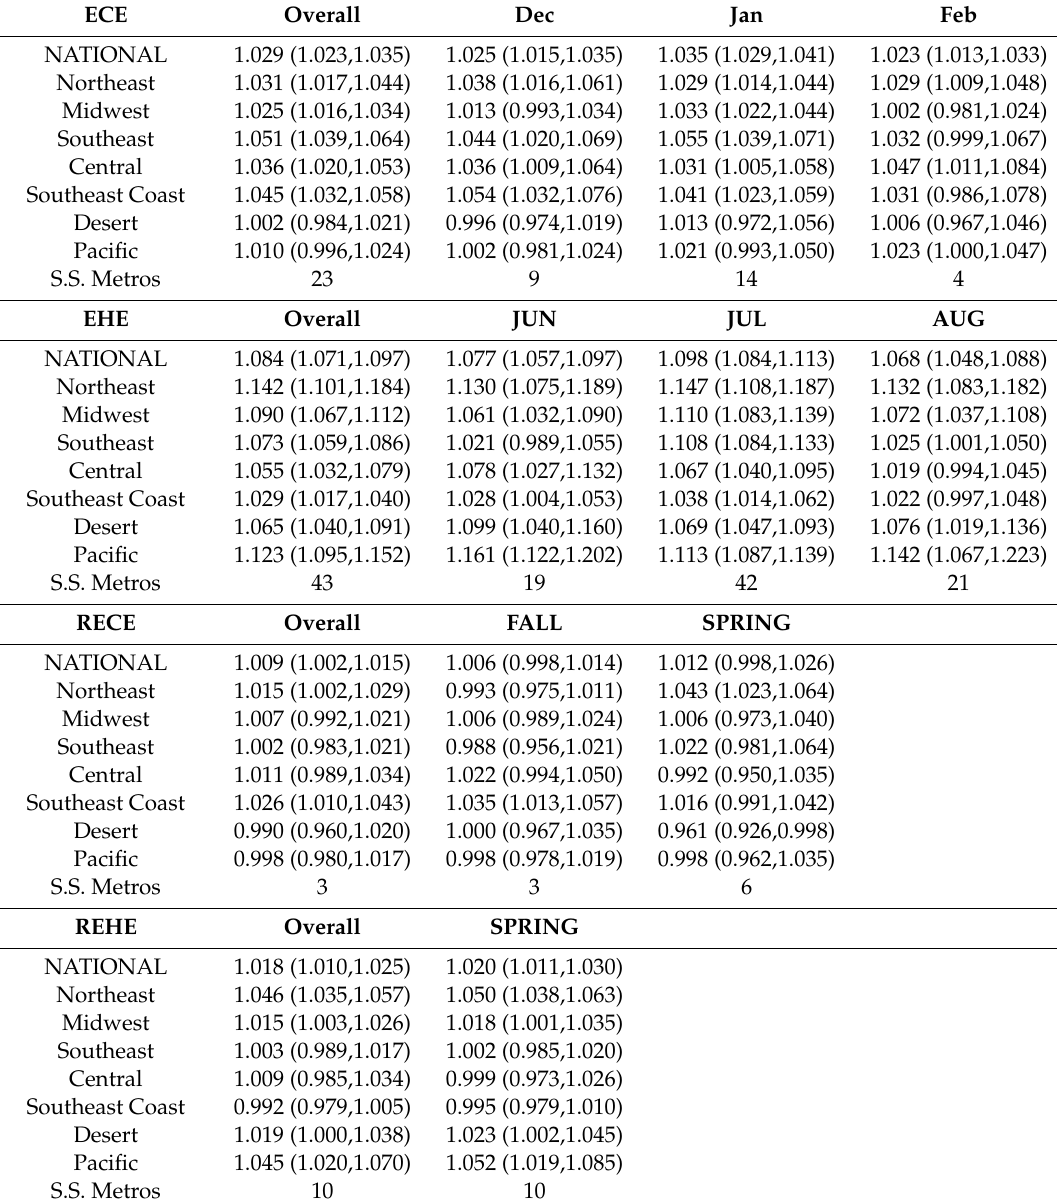
Table 4. Zero-dayrelativerisksforETEsbyregion,andnumberofstatisticallysignificantmetropolitan areas.